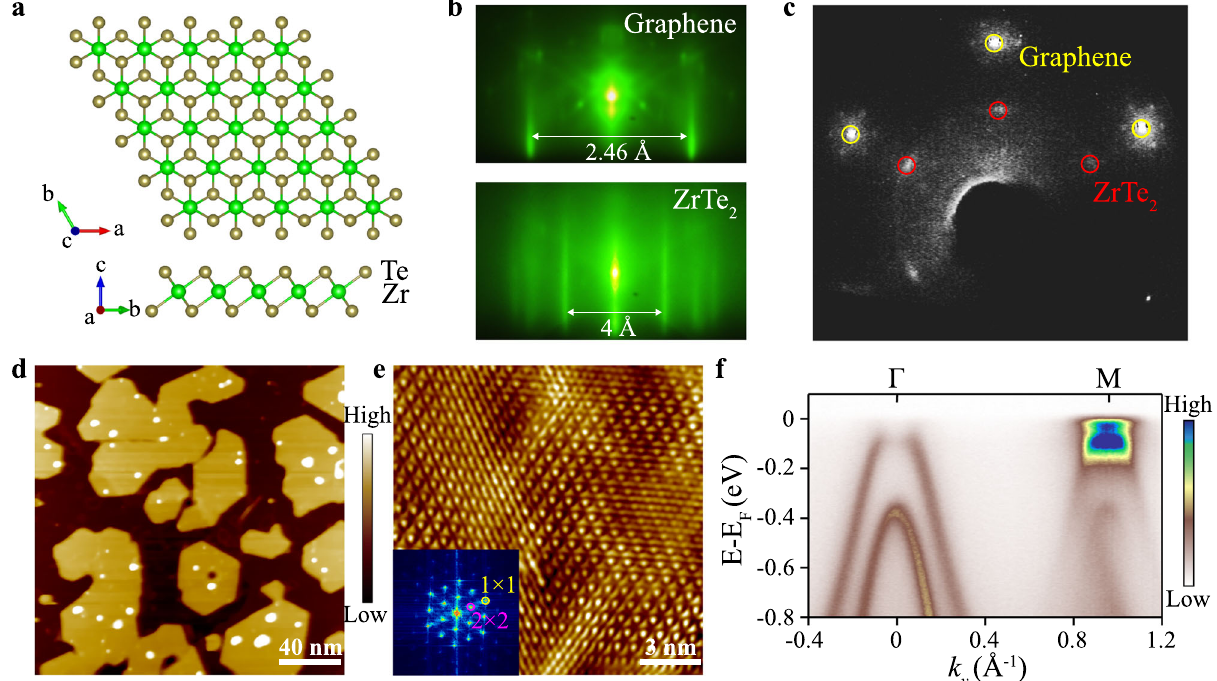
Fig.1|Structureandcharacterizationofepitaxiallygrownmonolayer1T-ZrTe 2 . with straight boundaries, dressed with a small number of particles that might a Schematic crystal structure of 1T-ZrTe 2 . 1T-ZrTe 2 in the top (top panel) and be amorphous ZrTe compounds or tiny 1T-ZrTe 2 islands. Some 1T-ZrTe 2 side (bottom panel) views. b RHEED patterns of graphene substrate (top metry of 1T-ZrTe 2 single crystal. e Atomically resolved STM image of a panel) and sub-monolayer 1T-ZrTe 2 (bottom panel). c LEED pattern after the fi lm growing on the graphene. d STM image of monolayer 1T-ZrTe CDW-related 2× 2 superstructure at 4.5K [ V bias = − 50mV, I = 200pA, 15 nm × 2 at 300K [ V bias = − 2.8 V, I = 200 pA, 200nm × 200nm]. Dark regions correspond to the 15nm]. The insert is the corresponding FFT. f ARPES measured band BLG substrate, and the 1T-ZrTe 2 layer is orange, which is in the form of islands structure along the Γ -M direction at T = 15